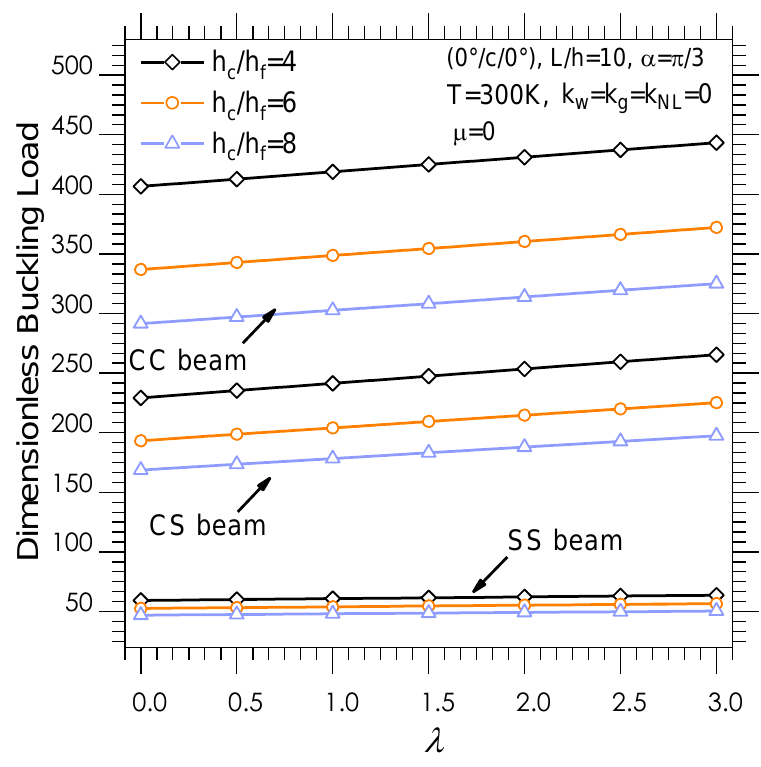
Figure 8. Dimensionless buckling load versus the length scale parameter.